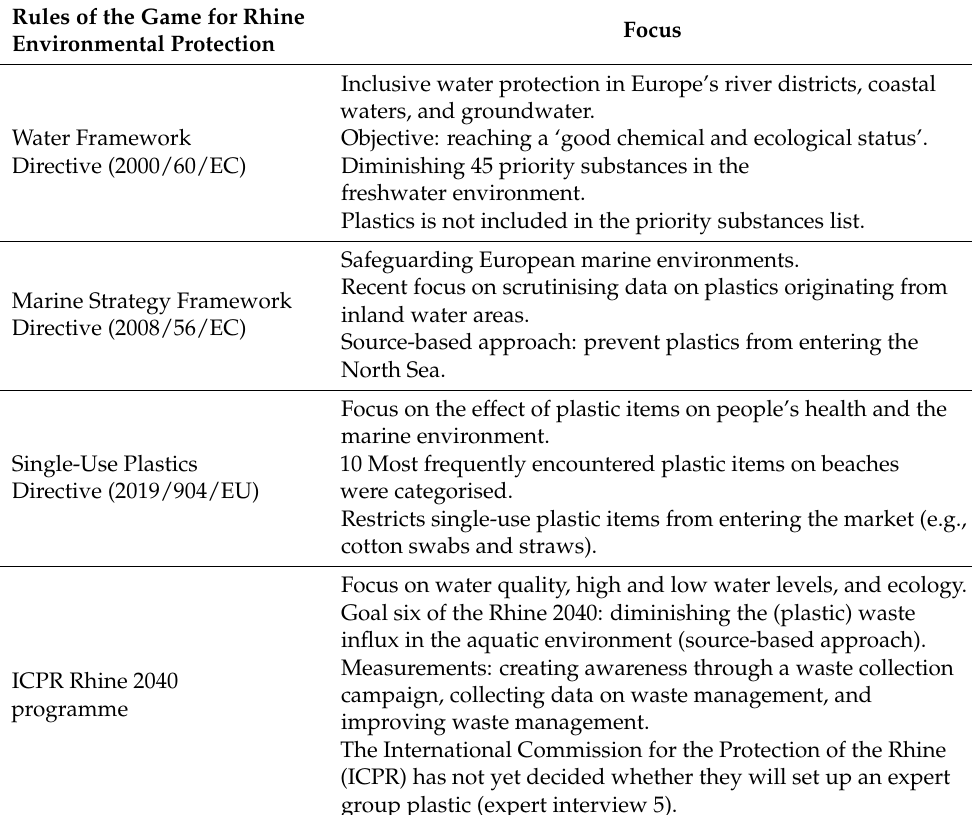
Table 3. Rules of the game dimension for environmental protection of the